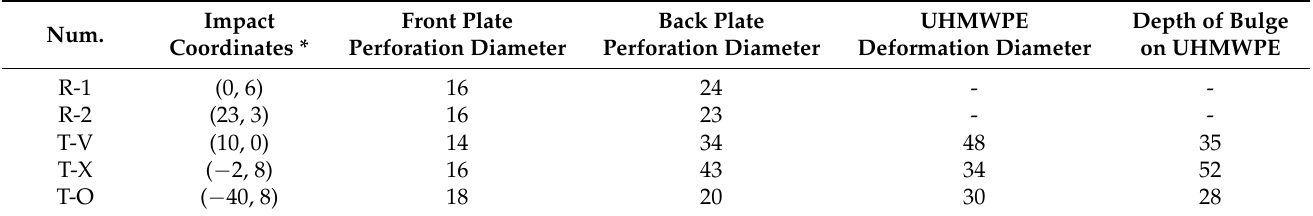
Table 3. Deformation of the test and reference structure after projectile